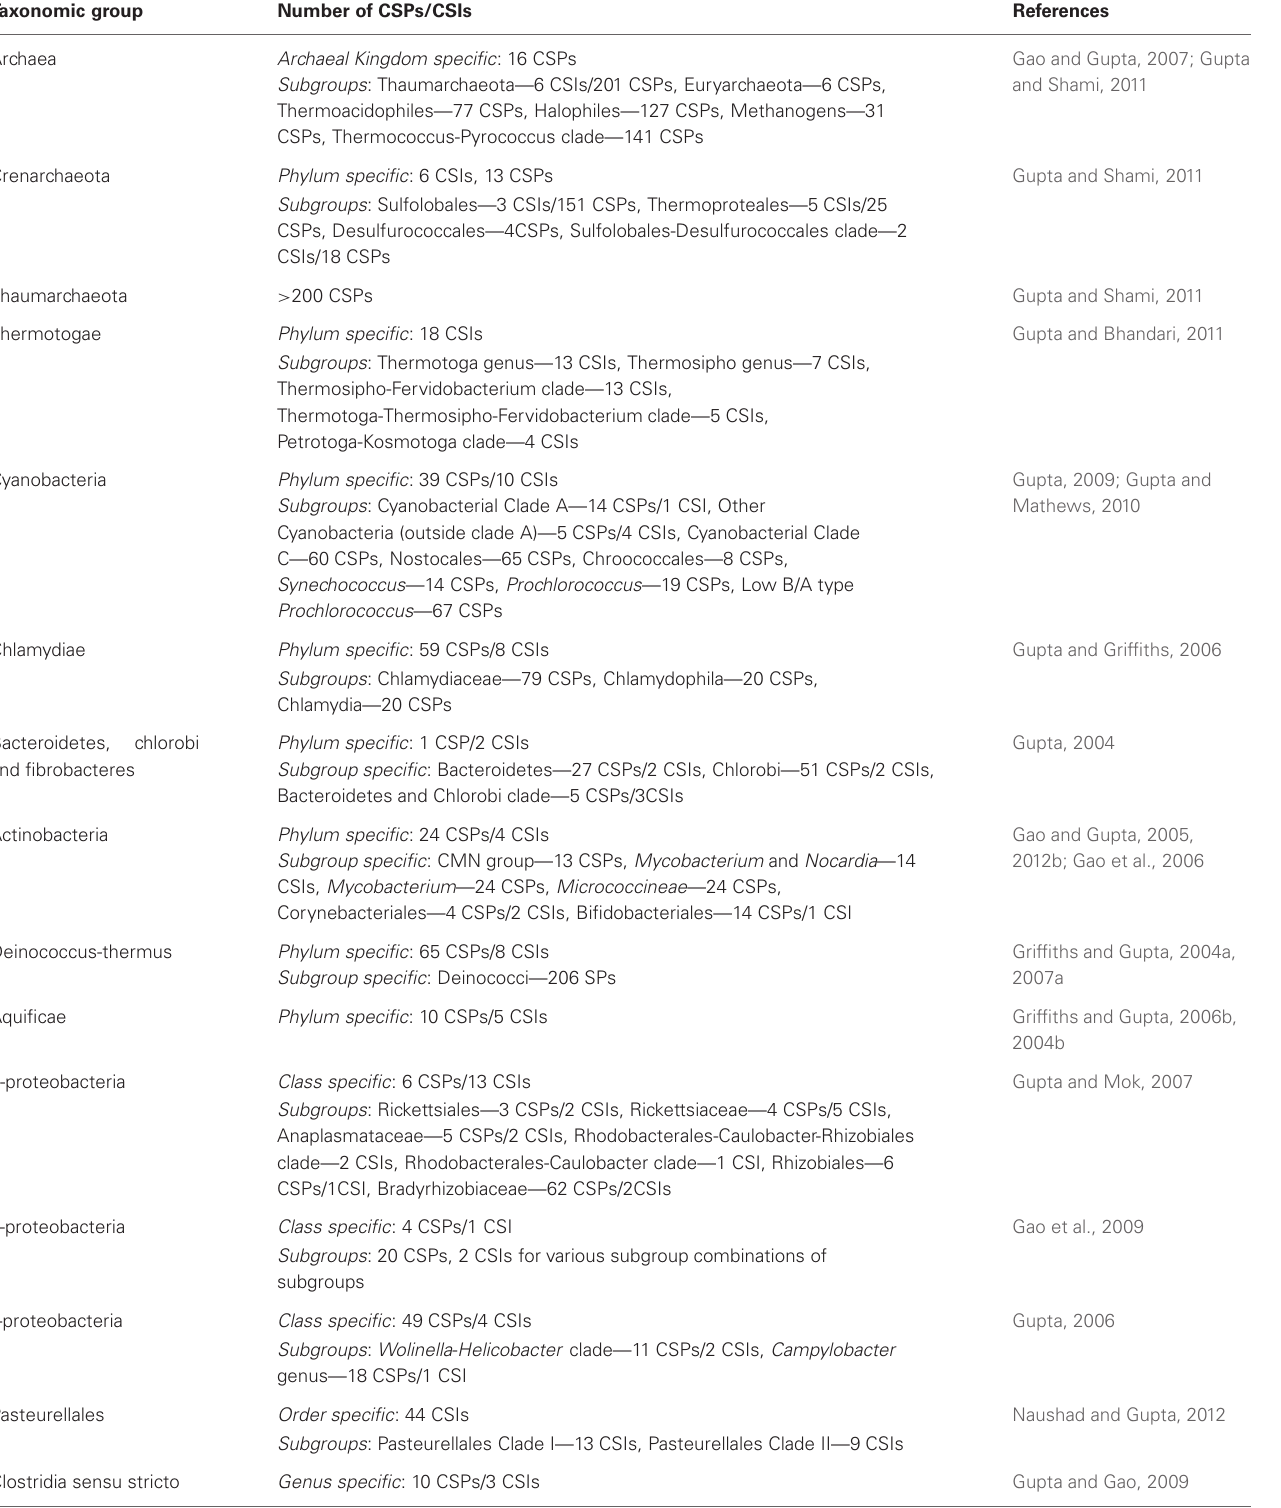
Table 1 | Overview of the CSIs and CSPs that have been identified for some major prokaryotic